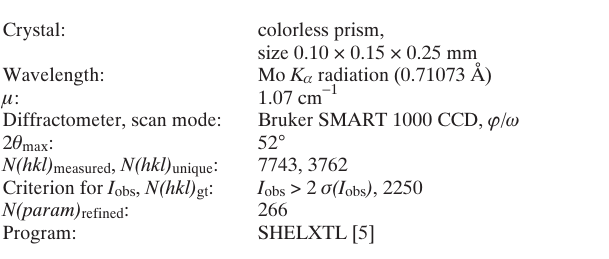
Table 1. Datacollection and handling.